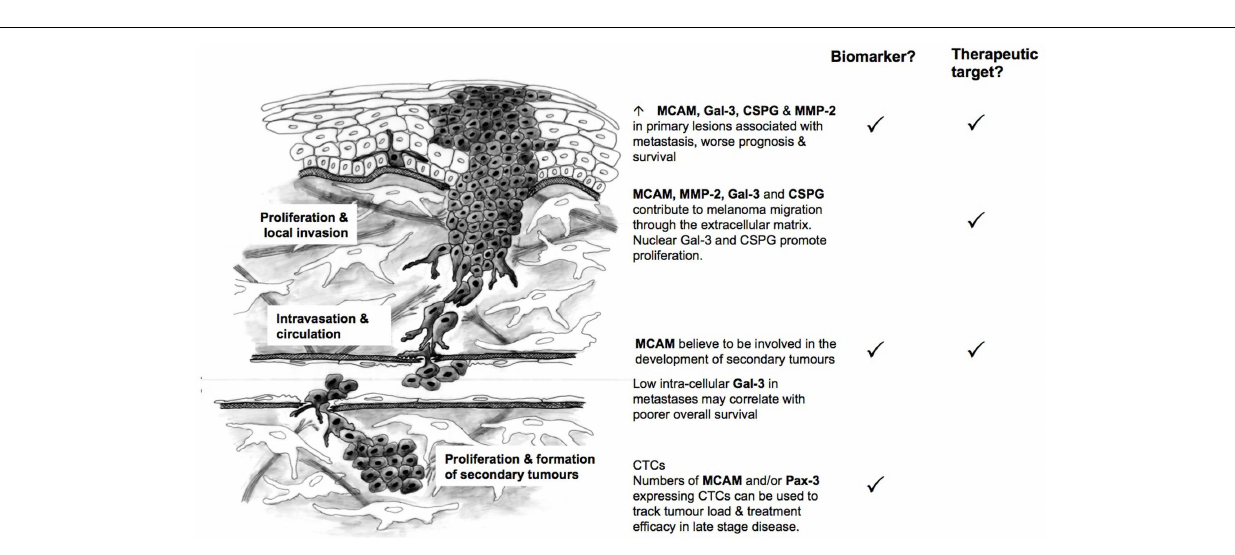
FIGURE 2 | MCAM, Gal-3, CSPG4, MMP-2, and PAX-3 as biomarkers and targets in melanoma metastasis